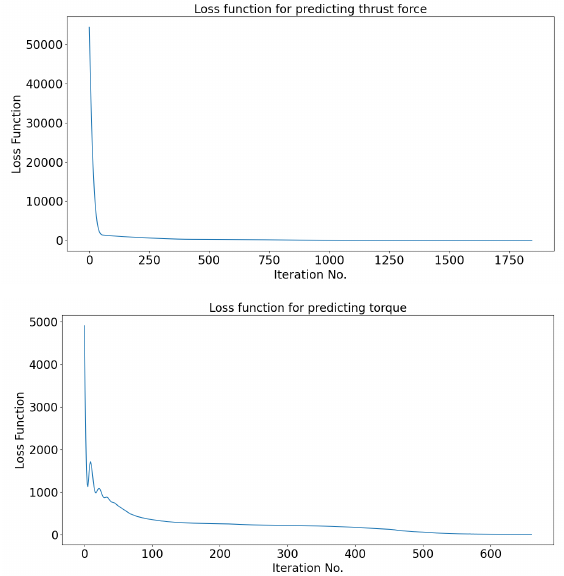
Figure 11. Converging loss values evaluated at each iteration of learning by the ANNs For each output parameter, a scatter plot with a trend line was made between the empirical and predicted valu- es. These plots further clarify the quality of fit of the models to the data. The scatter plots are given below.